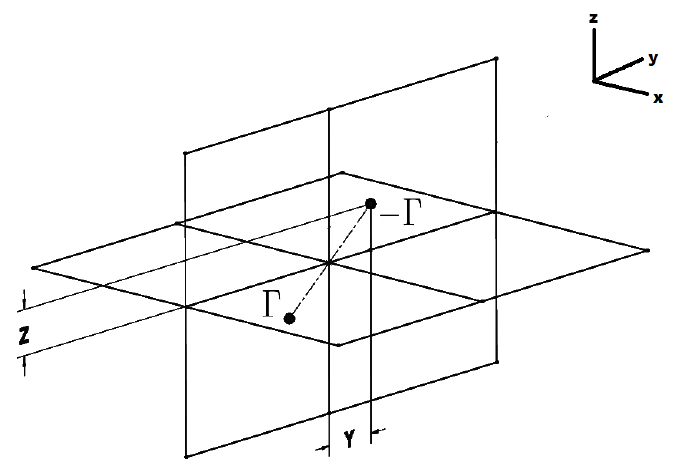
Figure 1. Schematic diagram of a three-dimensional heton with an anticyclonic point vortex (cir- culation − Γ ) initially located at ( 0, Y , Z ) and a cyclonic vortex (circulation Γ ) initially located at ( 0, − Y , − Z )